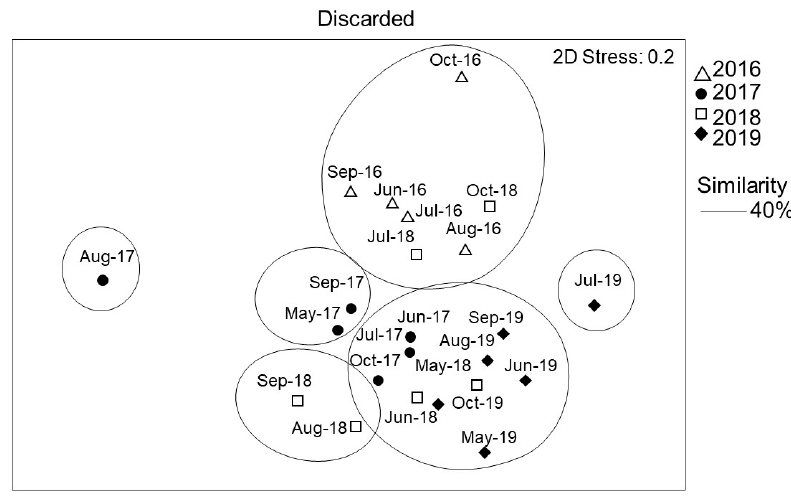
Figure 8. Non-metric multidimensional scaling ordination plots for discarded catches in the months of different years. Table 5. Summary results of SIMPER showing the average dissimilarity in the discarded species composition across the years studied and three species that contributed most to the overall dissim- ilarities.